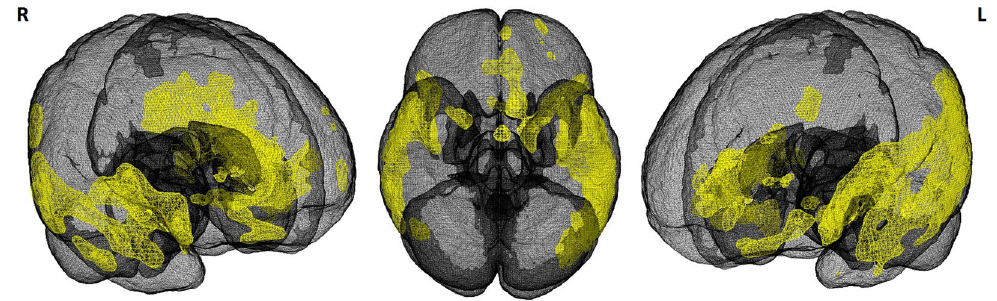
Figure 2. Brain atrophy in FTD patients with GluA3 antibodies. MRI scans were available in 18 FTD patients with anti-GluA3 antibodies (age: 62.4 ± 6.7, gender F: 38.9%) and were compared to 42 healthy controls (age: 61.0 ± 9.1, gender F: 66.7%) (SPM12 software package Wellcome Department of Imaging Neuroscience, London; http://www.fil.ion.ucl.ac.uk/spm). Statistical threshold was set at p < 0.05, Family Wise Error (FWE) corrected, with a minimum cluster size of 50